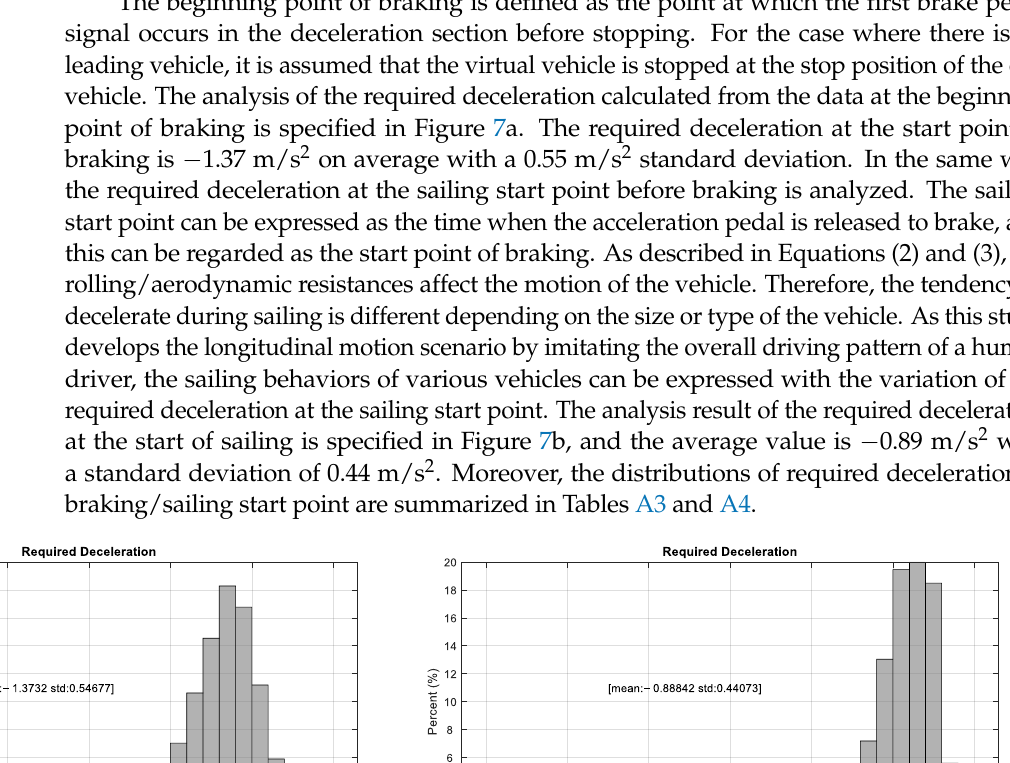
Figure 7. Distribution of required deceleration (300 random vehicles): ( a ) case of braking start point; ( b ) case of sailing start point.